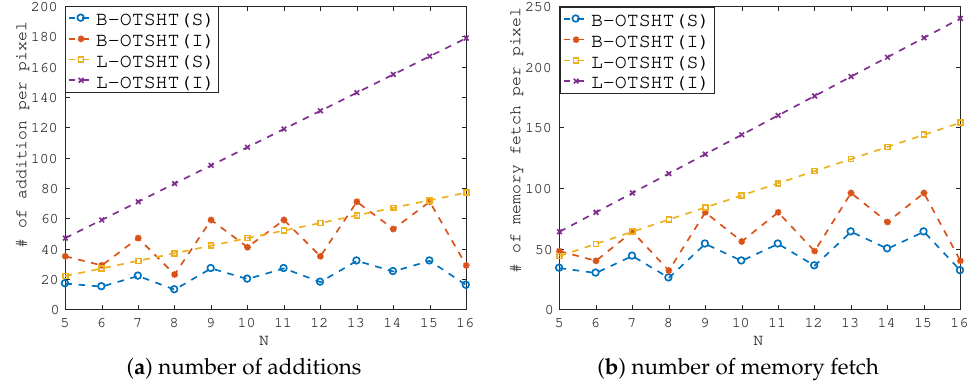
Figure 7. The number of operations per pixel for computing B-OTSHT and L-OTSHT coefficients using strip sum (S) and integral image only (I).